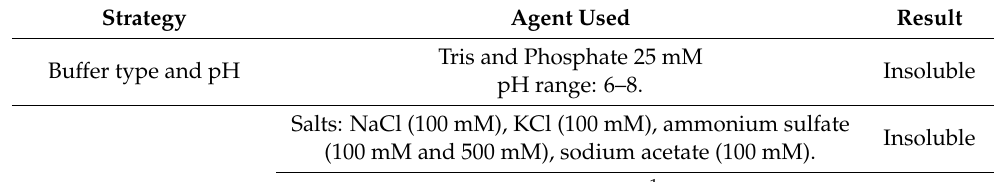
Table 1. MuRif1-CTD solubilization strategies and their effect.